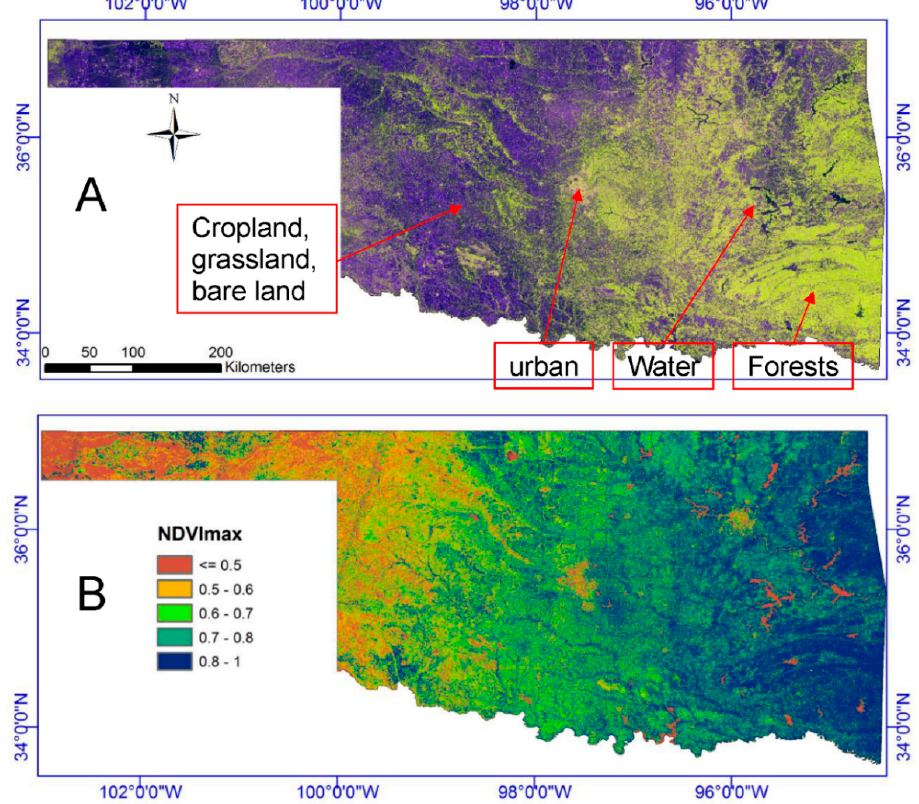
Figure 4. The spatial distribution maps of the false color composition of the ALOS PALSAR: ( A ) Red (HH), Green (HV) and Blue (HH-HV) and the annual maximum NDVI (NDVImax) values from Landsat TM/ETM+ images ( B ) in 2010.